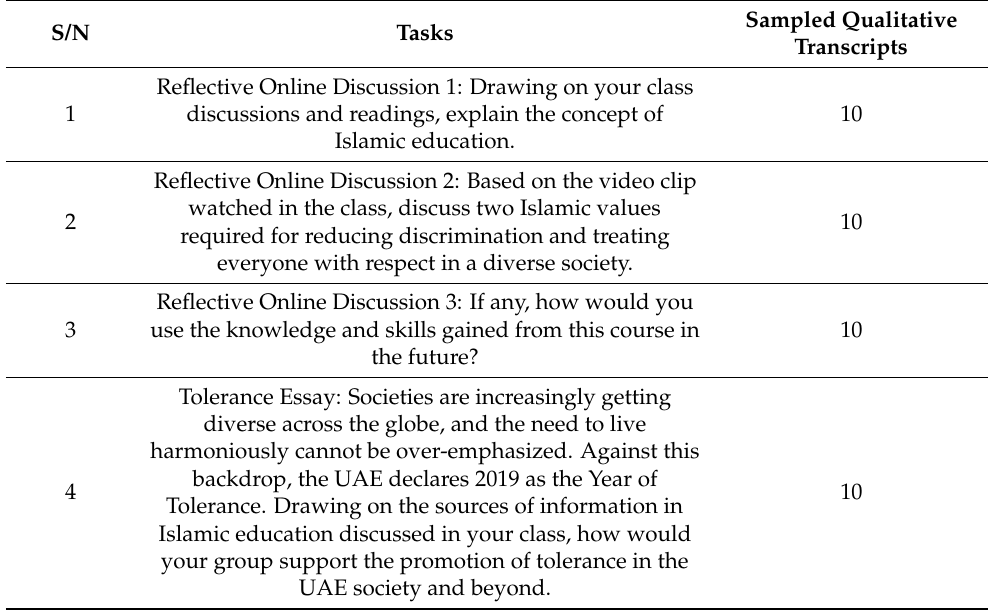
Table 1. Tasks and sampled